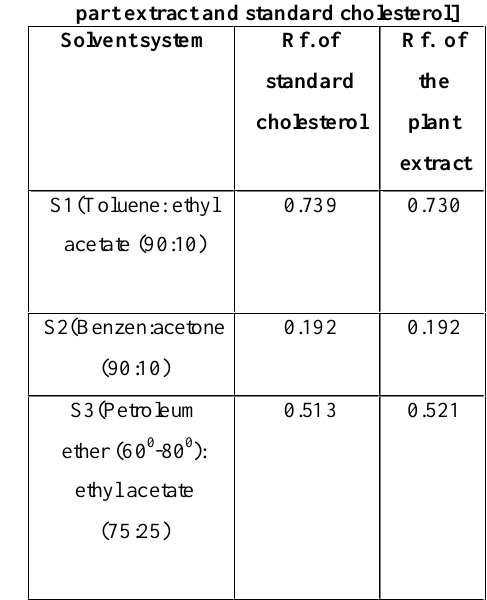
Figure (7): TLC plate of the aerial plant extract, and standard, using S3 mobile